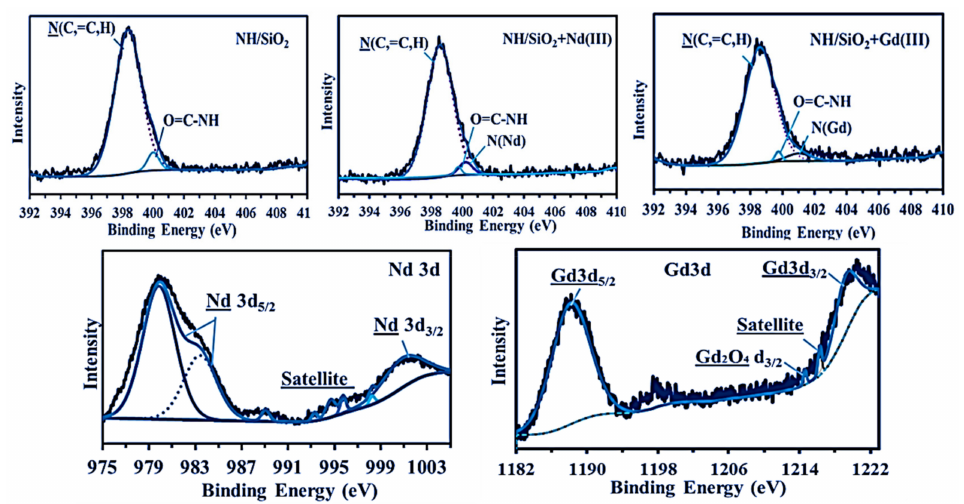
Figure 5. High-resolution (HRES) XPS spectra of N 1 s for either loaded and non-loaded sorbent and Nd or Gd 3 d